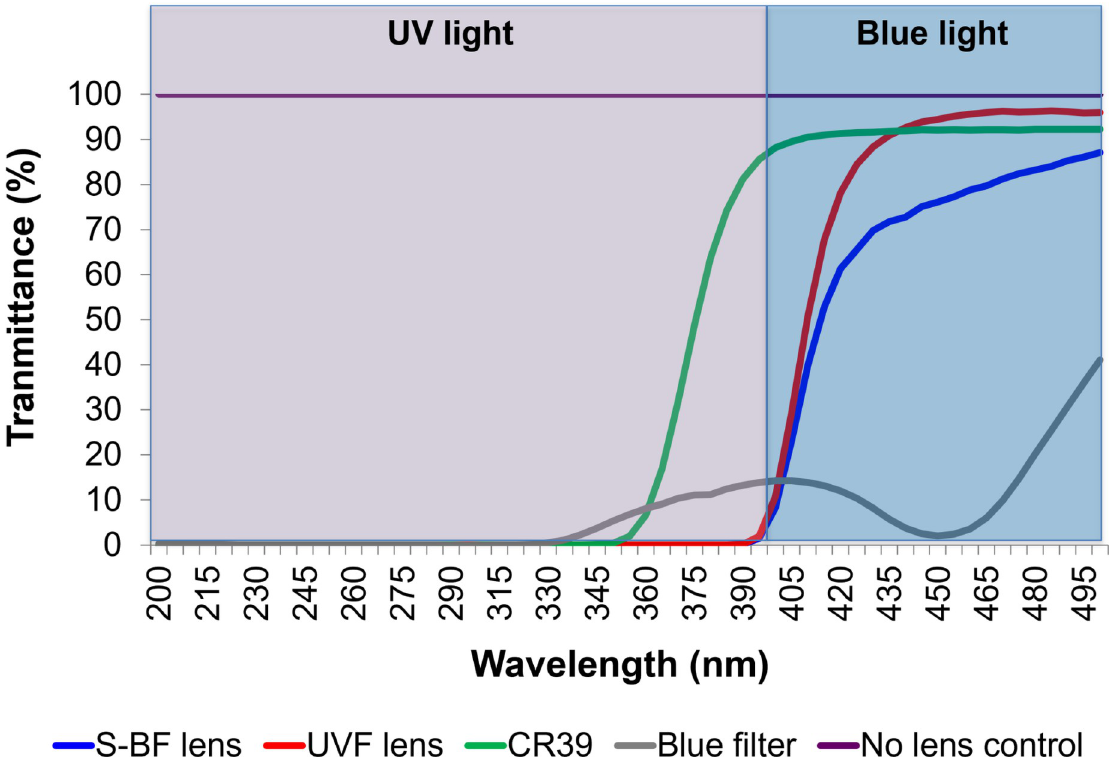
Fig 3. Transmittance of different spectacle lenses as measured by a spectrophotometer. Selective blue-filtering (S-BF) lens reduced 17% more visible blue light compared to the ultraviolet-filtering (UVF) lens, and reduced 35% more blue light compared to the CR39 lens. The blue filter significantly reduced the blue spectrum. The CR39 lens did not have any coating and allowed most blue and some UV light to pass through. A control without any lens allowed 100% transmittance for all wavelengths.